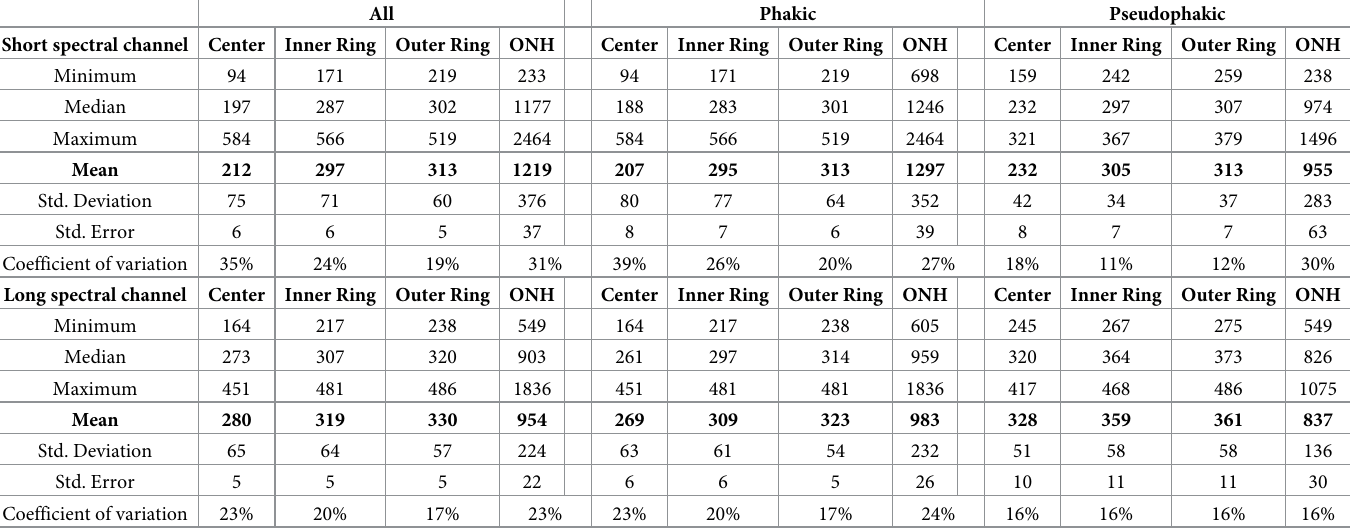
Table 2. Mean fluorescence lifetime values of specific regions of interest in the short (498-560nm) and the long (560-720nm) spectral channel for all subjects phakic and pseudophakic